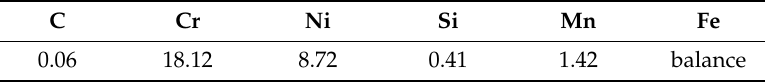
Table 1. Chemical composition of the raw materials (wt %).